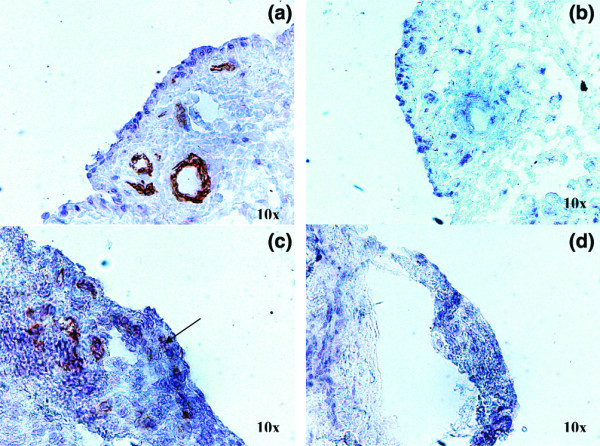
α-Smooth muscle actin (α-sma) staining in healthy and arthritic synovial tissue. (a) No α-sma staining was found in the lining layer of healthy synovial tissue. (c) In synovial biopsies from rheumatoid arthritis patients, cells positive for α-sma expression were found in the lining layer. Relative isotype controls are shown in (b,d). Arrows indicate α-sma positive cells from the lining layer.